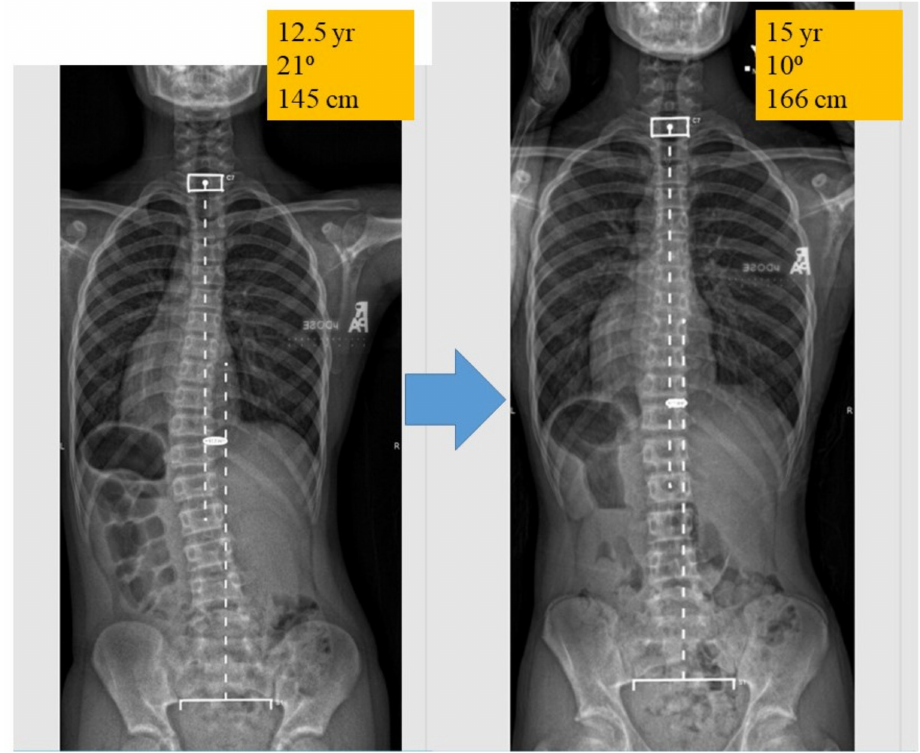
Figure 7. Spine X-rays of a male patient who was first diagnosed at 12.5 years old with a 21-degree curve. Environmental and lifestyle modifications were implemented like upper limb exercise, posture awareness, and change of seating furniture. His curve reverted to 10 degrees at the age of 15 years old and the follow-up x-ray was taken after he had passed through his peak growth spurt. Bracing was not prescribed in this case. This case demonstrates that soft tissue remodeling is feasible in some selected